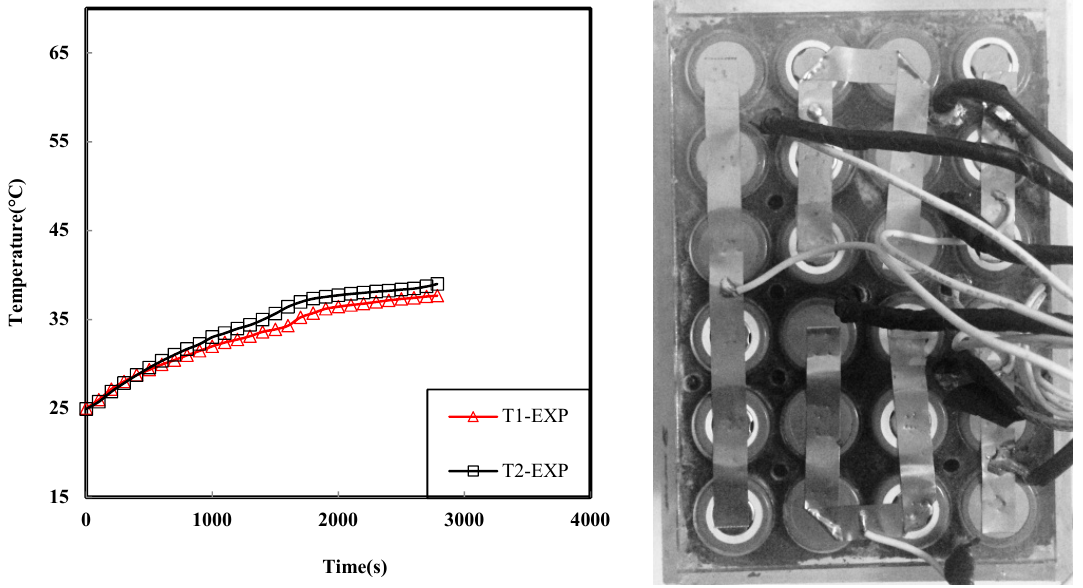
Figure 5. The temperature curve of the battery module and an image of the test setup using PCM under a 1.5C discharging rate.